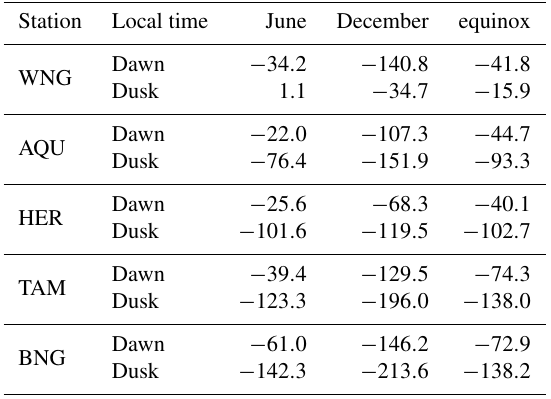
Table 2. Mean deflections of the H component (in nT) from the years 2001–2005 at five observatories for different seasons during active times (Kp > = 6). Dawn values are from 03:00 + 04:00UT hourly averages and 16:00 + 17:00UT averages for the dusk sec- tor.